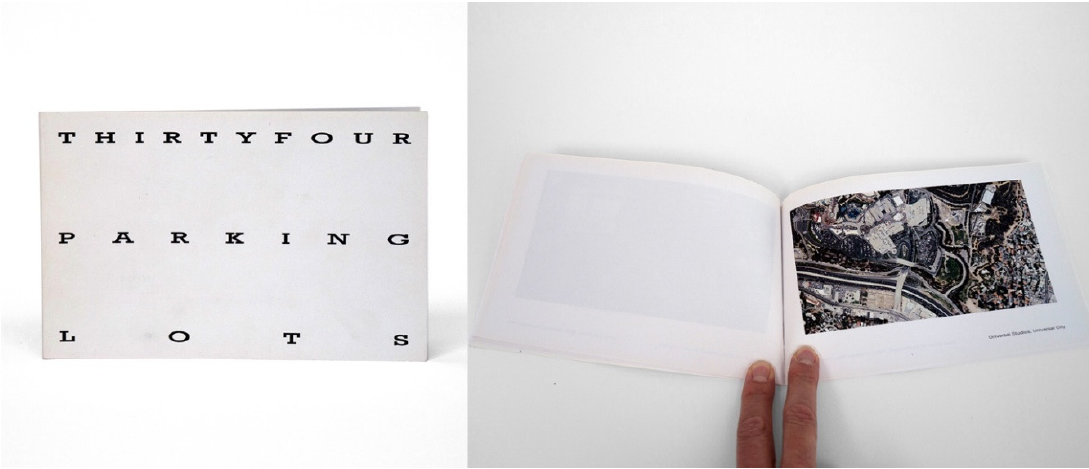
Figure 21. Travis Shaffer, Thirtyfour Parking Lots in Los Angeles… via Google Maps , 2008.